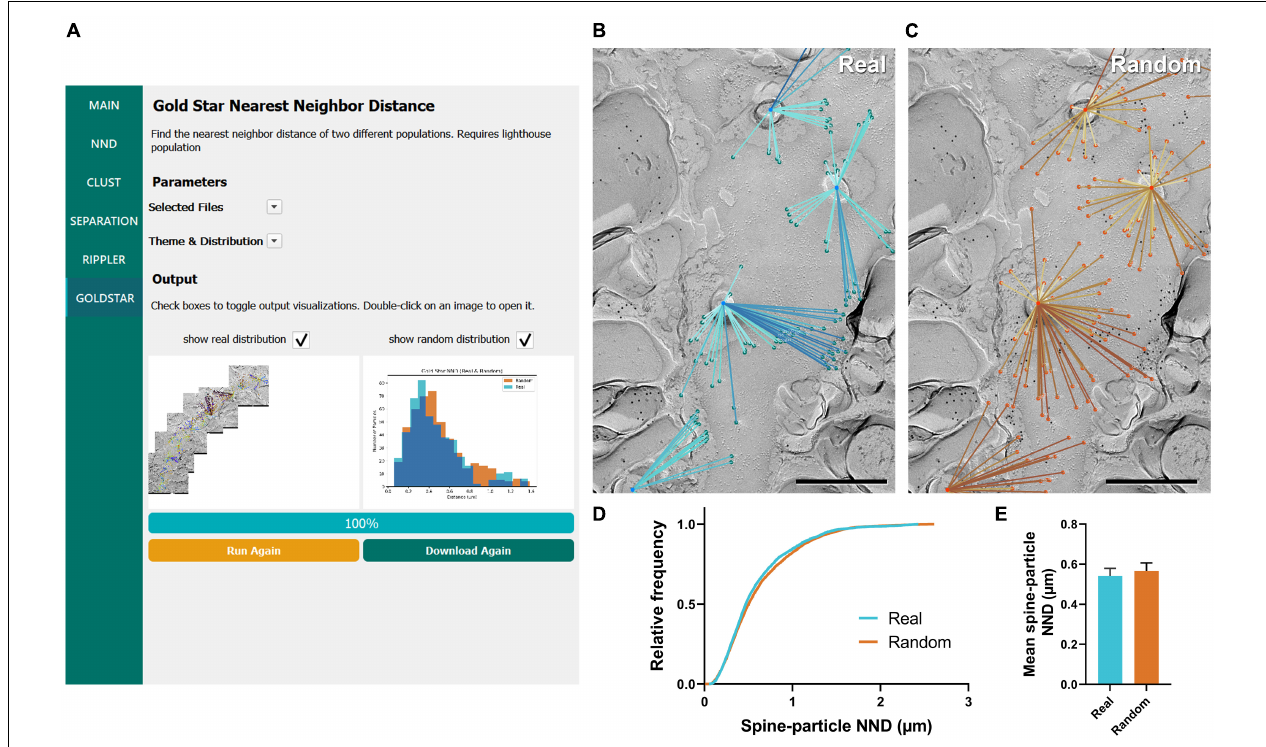
FIGURE 7 | GIO interface of Gold Star as a method for determining NNDs of particles to a landmark feature. (A) GIO interface showing the Gold Star workflow. A labeled image of the ROI is displayed along with a histogram of the NNDs to a landmark feature, for real and/or random distributions. (B) The Gold Star output of a portion of the Purkinje cell dendrite ROI image shown in Figure 5A . Dendritic spine neck cross-fracture is used as the landmark feature, and lines connect each particle (green) to the center of the nearest spine neck. (C) The Gold Star output for a random distribution of particles (orange) superimposed on the same ROI. (D) Cumulative frequency distribution of real and random spine-particle NNDs pooled across the 11 ROIs. (E) Grand mean spine-particle NND. Error bars represent S.E.M. n = 11 ROIs. Scale bars: 500